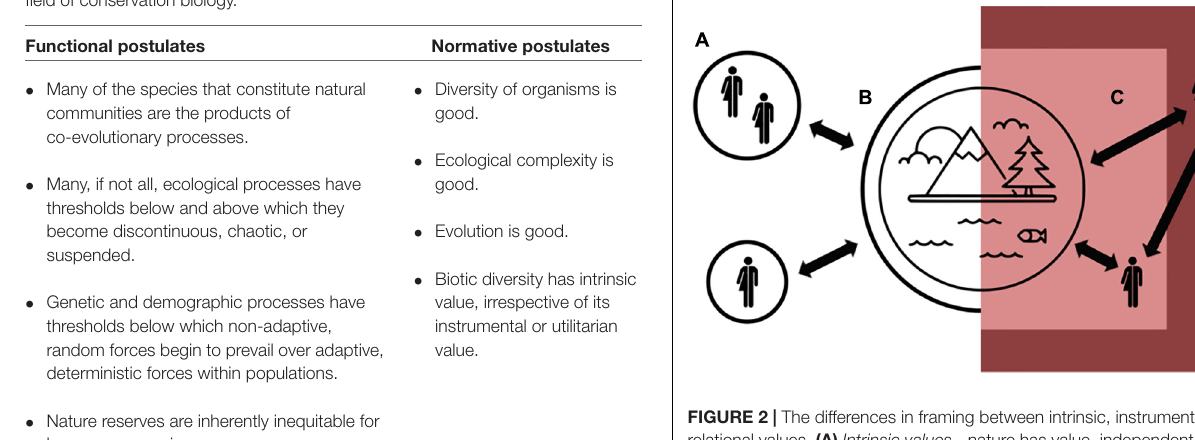
FIGURE 2 | The differences in framing between intrinsic, instrumental, and relational values. (A) Intrinsic values - nature has value, independent of people, (B) instrumental values - being in/seeing nature brings people pleasure or satisfaction, (C) relational values (individual) – nature can contribute to an individual’s identity, may create feelings of eudemonia through the virtue of stewardship or caring for the land may be seen as a moral duty, (D) relational values (human collective) . Relationships between groups of people and nature can help define cultural identities, provide social cohesion, and create social or moral bonds of stewardship (adopted from Chan et al.,